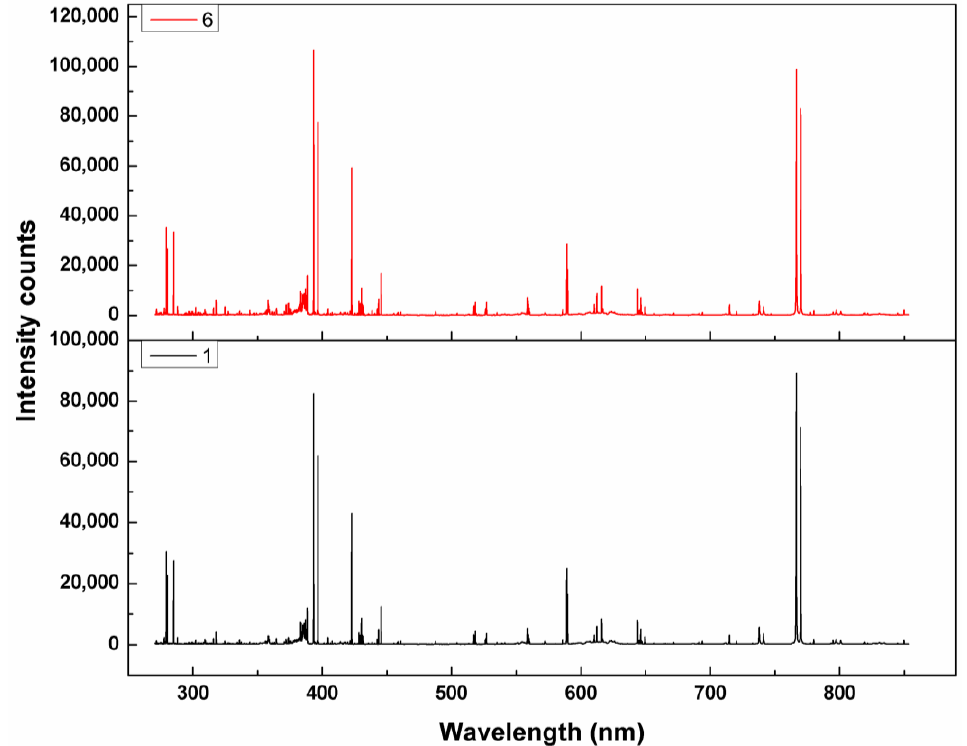
Figure 1. Typical LIBS profiles of the control group and pesticide residue group of mulberry fruit with two concentrations of the pesticide solution (0 g mL − 1 and 0.0001 g mL − 1